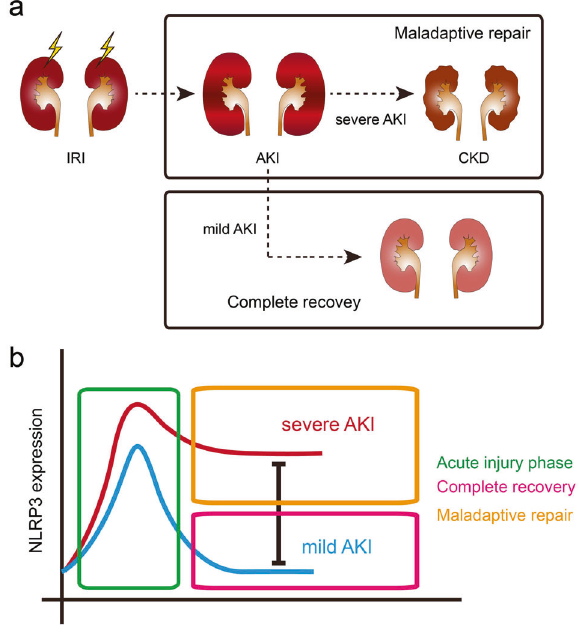
Fig. 6 A summary of NLRP3 dynamic alteration in initial tissue injury and subsequent repair of the kidney after acute kidney injury. a Renal maladaptive and incomplete repair would occur when kidney subjected to severe IRI. b Renal maladaptive and incomplete repair would be accompanied with higher expression levels of NLRP3 in AKI-to-CKD